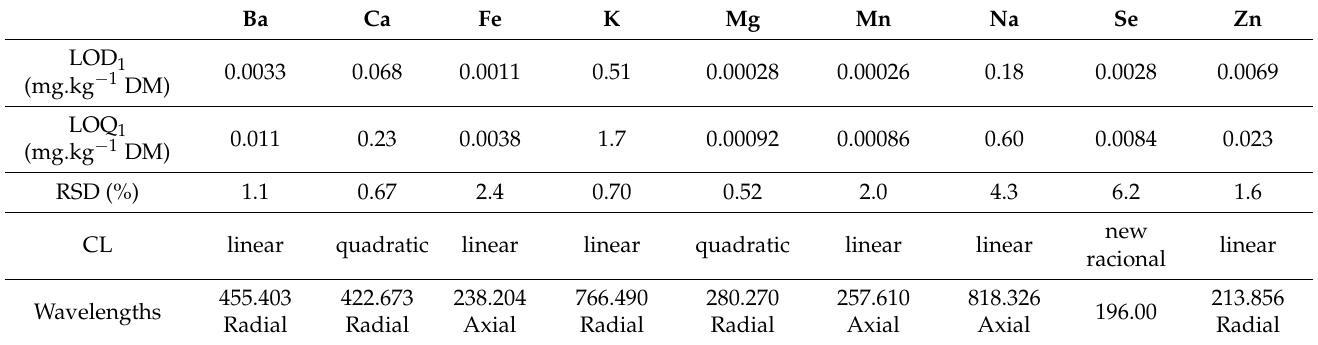
Table 2. The basic validation characteristics of the